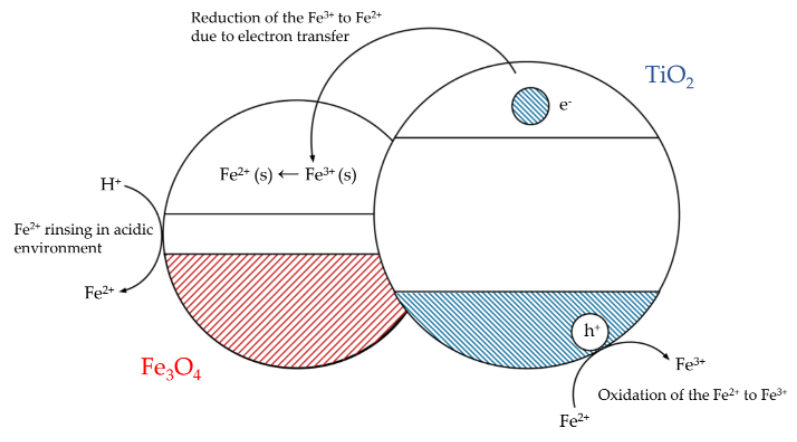
Figure 5. Possible reactions in Fe 3 O 4 /TiO 2 composite (drawn based on [101]).